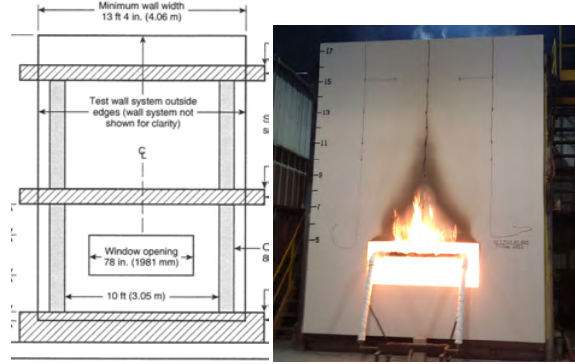
Figure 4: Example of fire test acc. to NFPA 285 procedure.